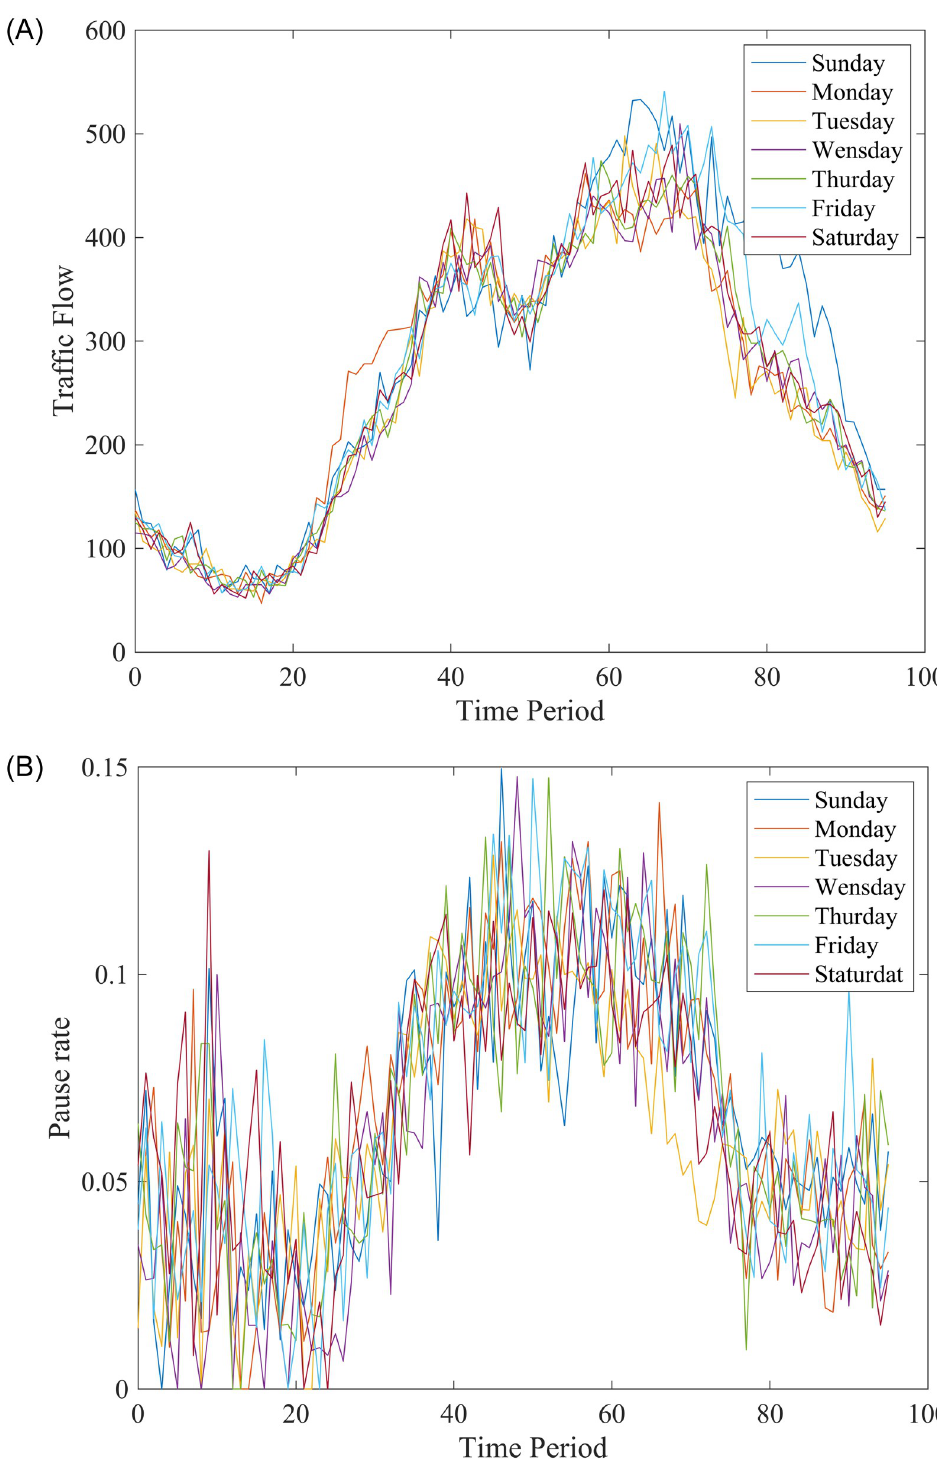
Fig 5. Time dependence of traffic flow and pause rate change curve. A: Time dependence of traffic flow. B: Time dependence of pause rate.